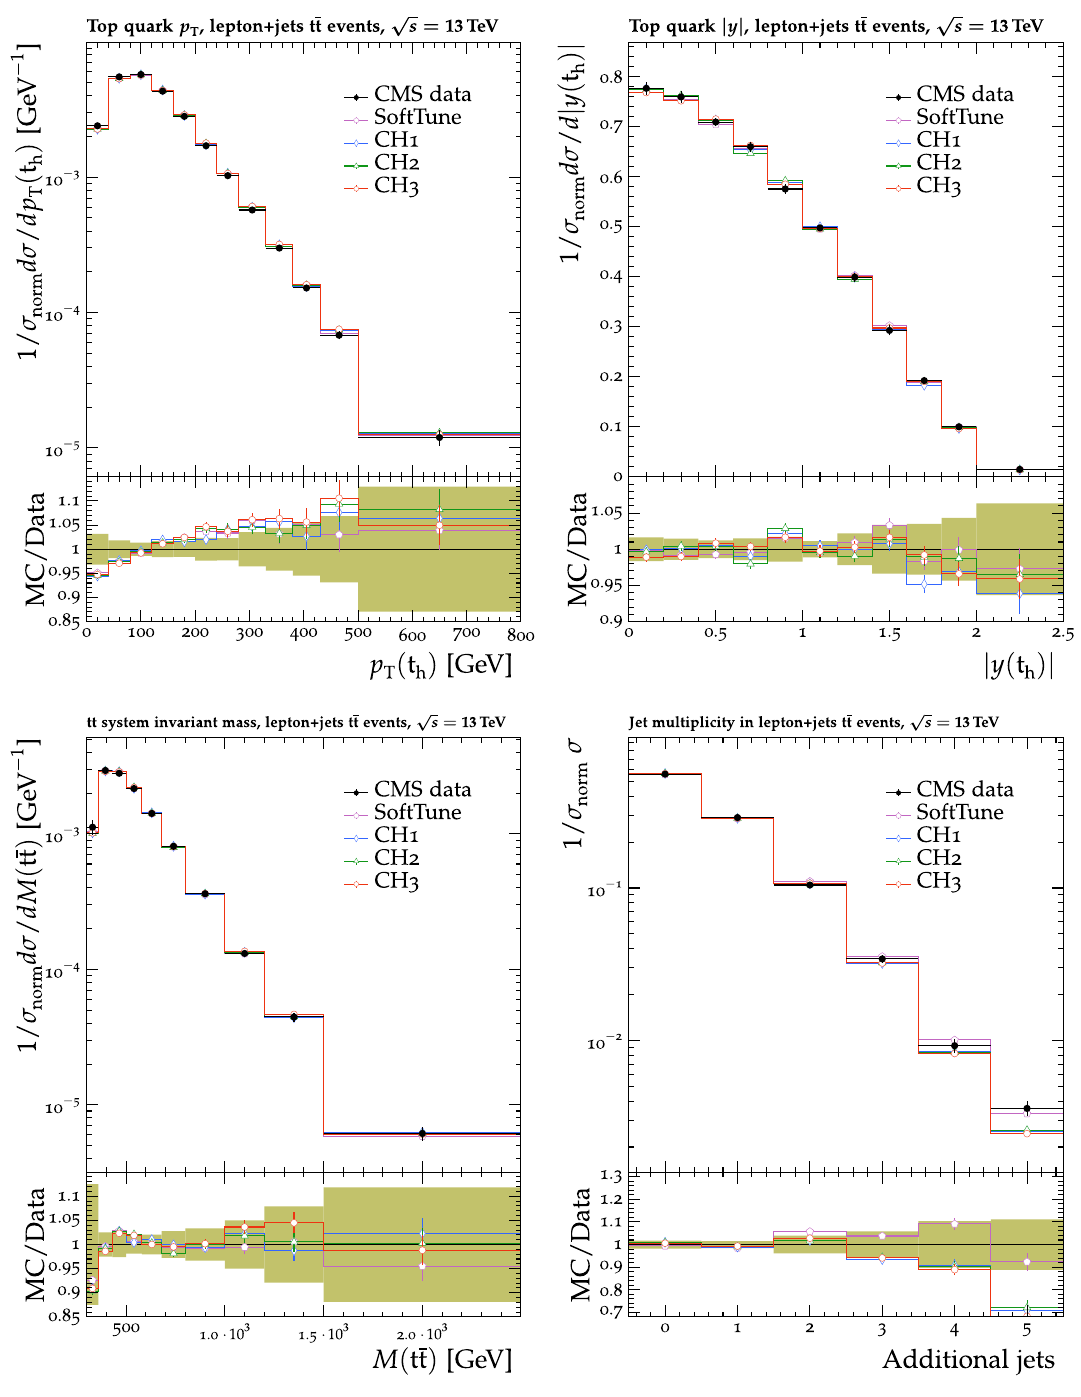
Fig. 12 The differential cross sections are shown as functions of: the p T (upper left) and rapidity (upper right) of the hadronically decaying top quark; the invariant mass of the t ¯ tsystem (lower left); the additional jet multiplicity (lower right) [38]. CMS t ¯ tdata are compared with the in the χ 2 ( Δχ 2 ) equal to the optimal χ 2 of the fit.